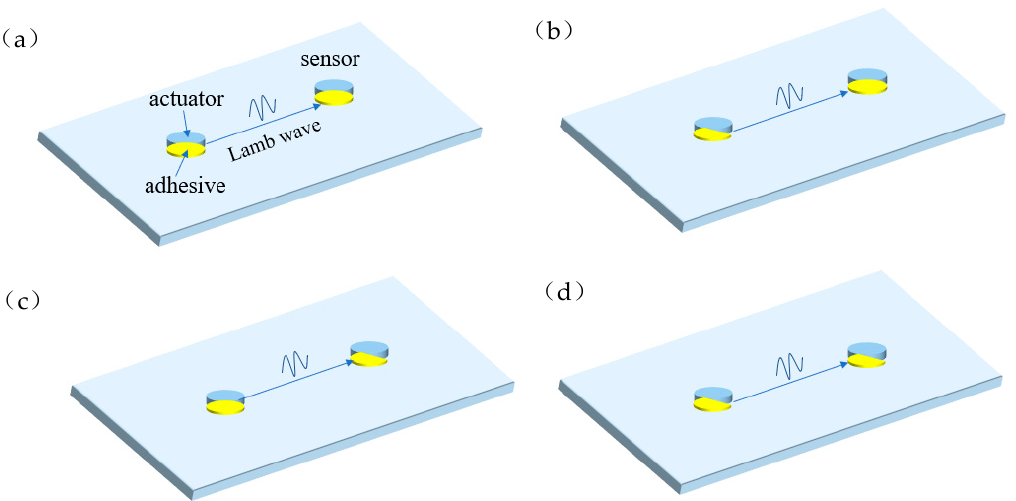
Figure 3. Propagation of Lamb wave on aluminum plate using pitch catch mode: ( a )excitation actuator and the receiving sensor are not debonded; ( b ) only actuator is debonded; ( c ) only receiving sensor is debonded; ( d ) both actuator and sensor are debonded.